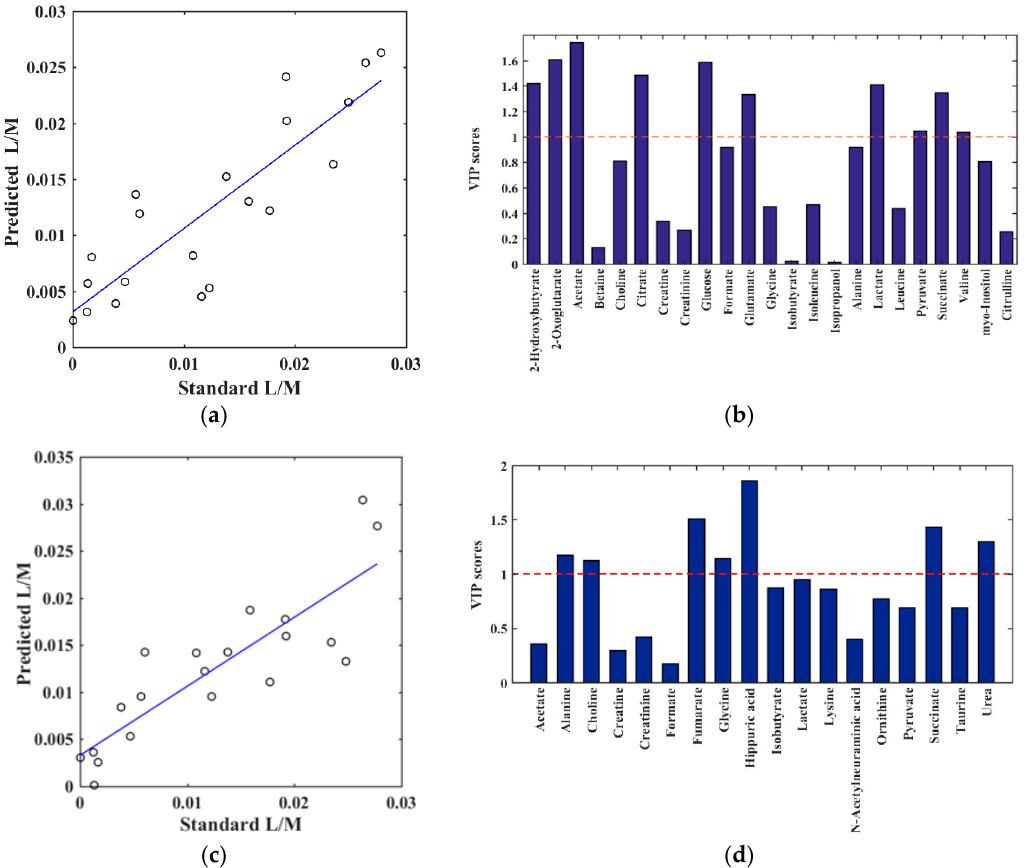
Figure 3. Results of partial least squares (PLS) regression models between the quantified NMR spectra (X-variables) and L/M ratio by enzymatic assay (y-variable). ( a ) and ( b ): Plasma metabolites and ( c ) and ( d ): Urine metabolites. For the plasma metabolites, the PLS model was obtained by one component, validated by leave-one-out method (R2 = 0.75, Q2 = 0.50 and root mean square error of cross validation (RMSECV) = 6.2 × 10 − 3 ). ( a ) plasma predicted versus quantified L/M, ( b ) plasma corresponding variable importance in projection (VIP) score plot, providing an estimation of the importance of each metabolite in PLS. A variable with a VIP score greater than 1 (dashed line) is considered important. For the urine metabolites, the PLS model was obtained by two components, validated by leave-one-out method (R2 = 0.73, Q2 = 0.51 and RMSECV = 6.2 × 10 − 3 ). ( c ) urine predicted versus quantified L/M, ( d ) urine VIP score plot.